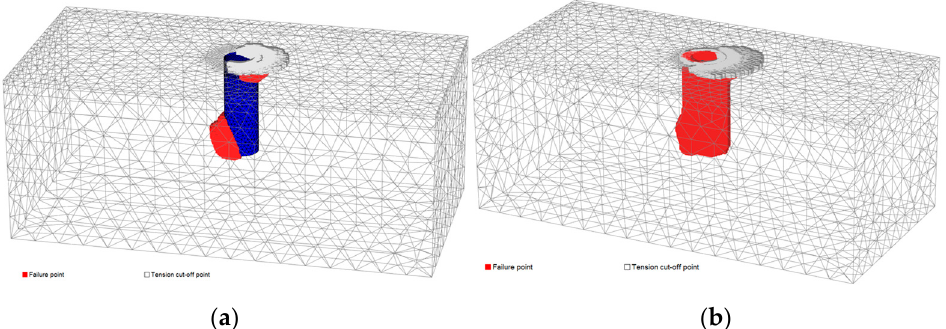
Figure 10. Distribution of the soil plastic zone under different thicknesses of the disturbance ring: ( a ) δ = 0 m; ( b ) δ = 2 m.